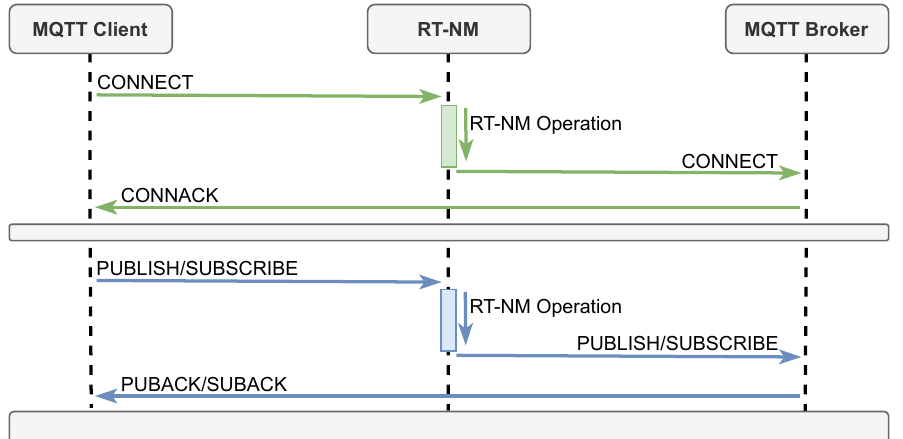
Figure 5. Message set up sequence